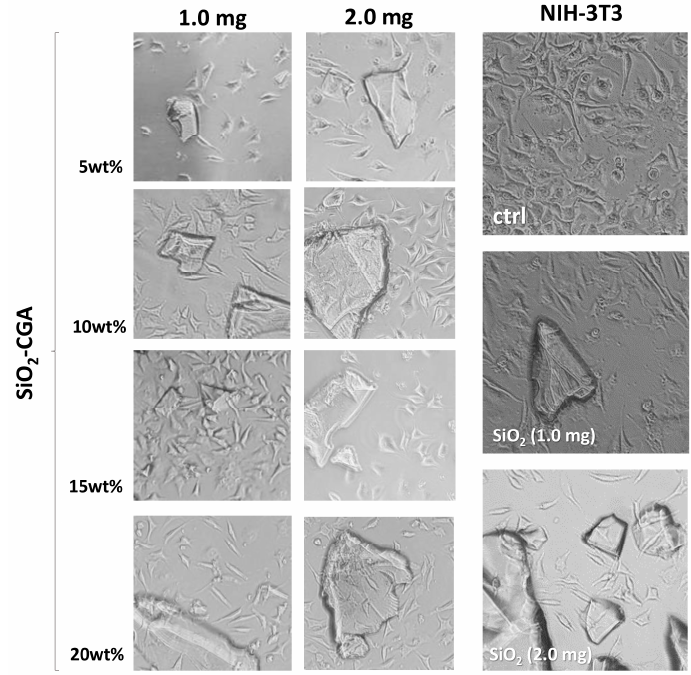
Figure 7. Morphological changes in hybrids- and SiO 2 -treated NIH-3T3 cells. Representative images were acquired by an inverted phase contrast brightfield Zeiss Primo Vert Microscope. Ctrl = untreated cells.